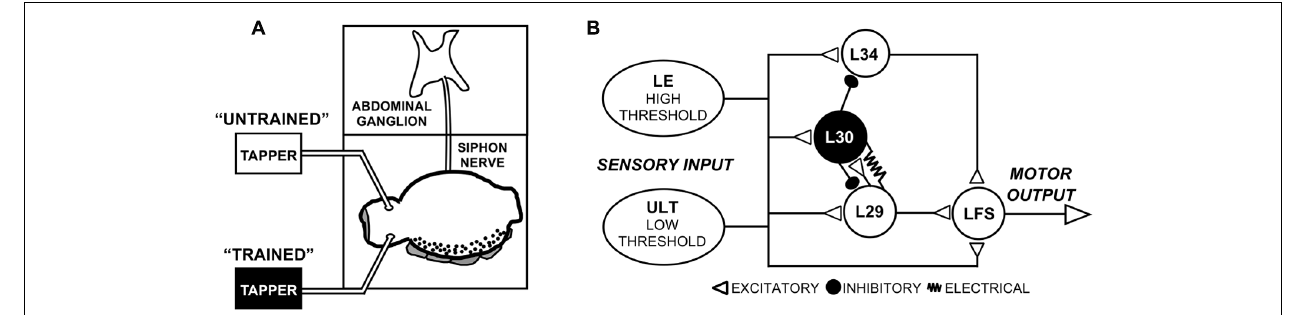
site-specificity of training, as illustrated. (B) Simplified version of the SWR network emphasizing the major elements in the reflex circuit. While only one cell of each type is shown, cells are multiply represented in the network. Two parallel sensory pathways from the siphon provide excitatory input, the lower threshold ULTs and the higher threshold LEs. Figure modified from Fischer etal.